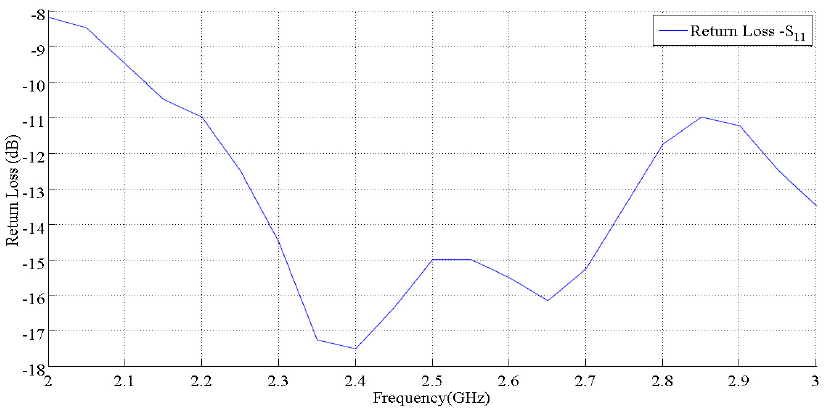
Figure 11. The actual matching circuit return loss ( S 11 ).